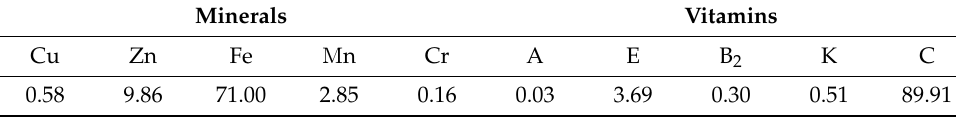
Table 1. The vitamin and mineral content in the functional product, mg/100